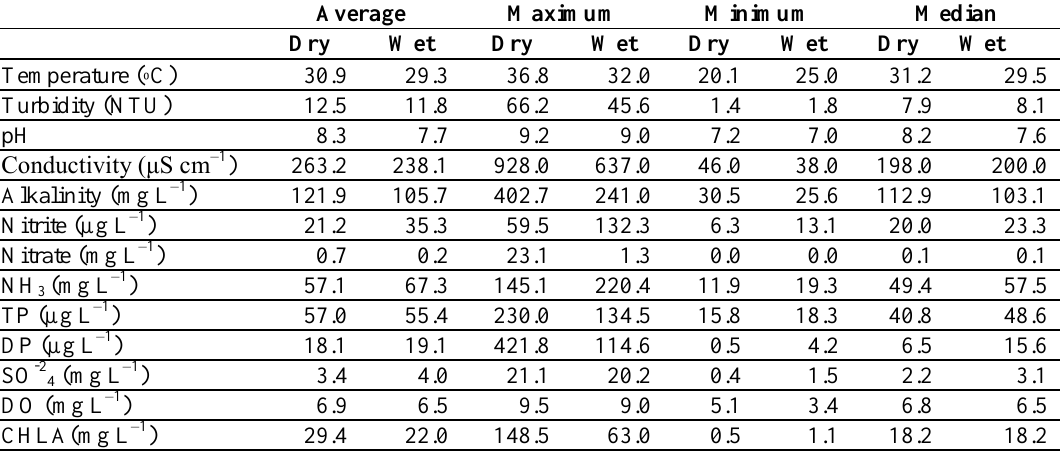
Table 1: Minimum, maximum, mean and median of Environmental data of 38 study reservoirs during the wet and dry season (October 2010 – January 2012) Abbreviations: TP = Total Phosphorus; DP = Dissolved Phosphorus; CHLA = Chlorophyll-